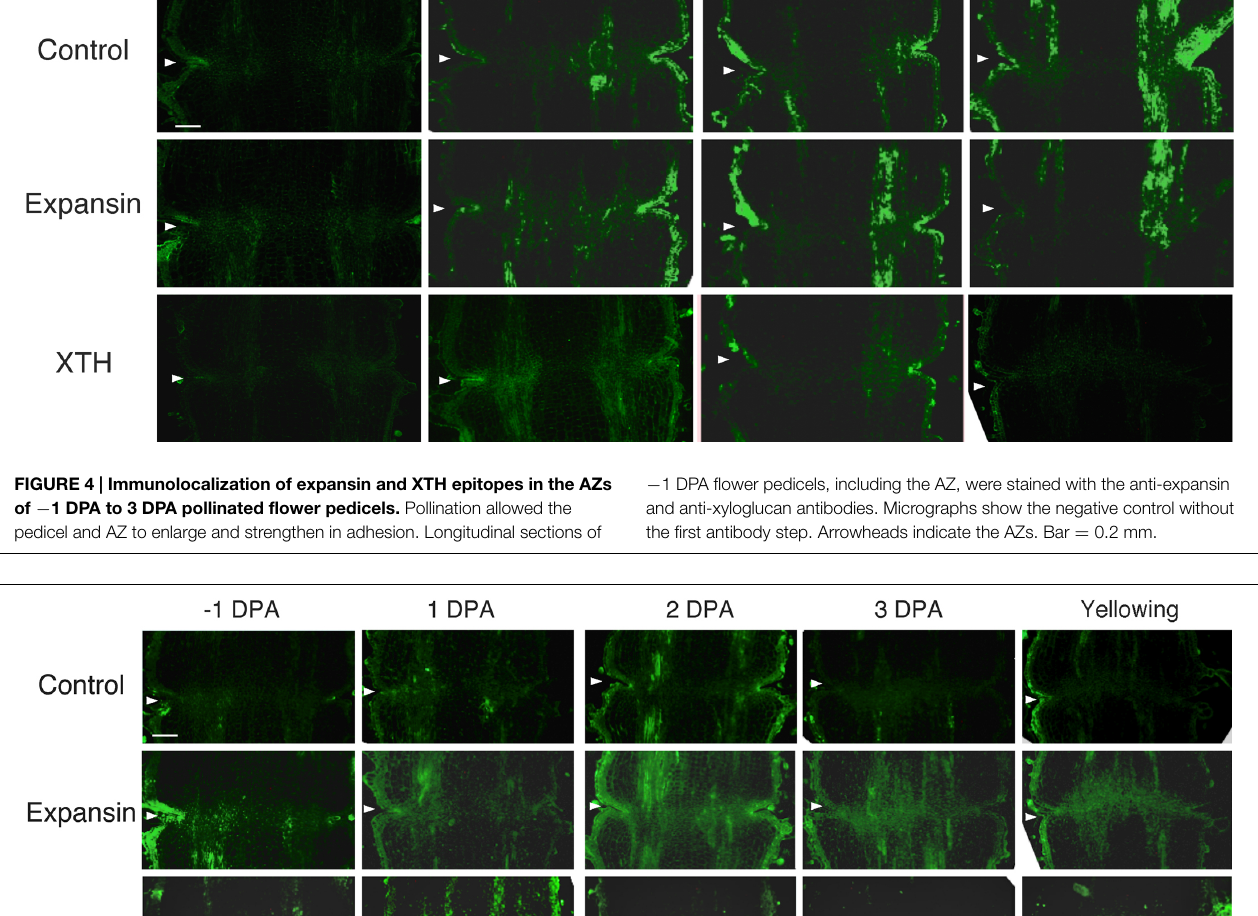
FIGURE 5 | Immunolocalization of expansin and XTH epitopes in the AZs of (cid:0) 1 DPA to yellowing unpollinated flower pedicels. Unsuccessful pollination led to flower abscission. Longitudinal sections of (cid:0) 1 DPA flower